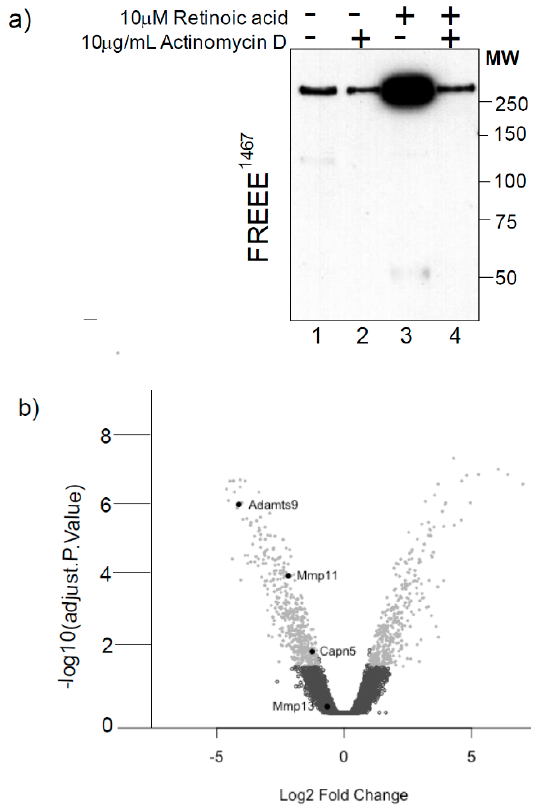
Figure 2. Identifying candidate aggrecanases in TS4/5 ∆ cat mice. ( a ) Aggrecanase cleavage in TS-4/5 ∆ cat femoral head cartilage explants, cultured untreated (lane 1) or in the presence of actinomycin D (lane 2), retinoic acid (lane 3) or both actinomycin D and retinoic acid together (lane 4) was analysed by FREEE 1467 neo-epitope Western blotting. ( b ) The results of the microarray studies, represented as a volcano plot, identify candidate proteinases for the novel aggrecanase.